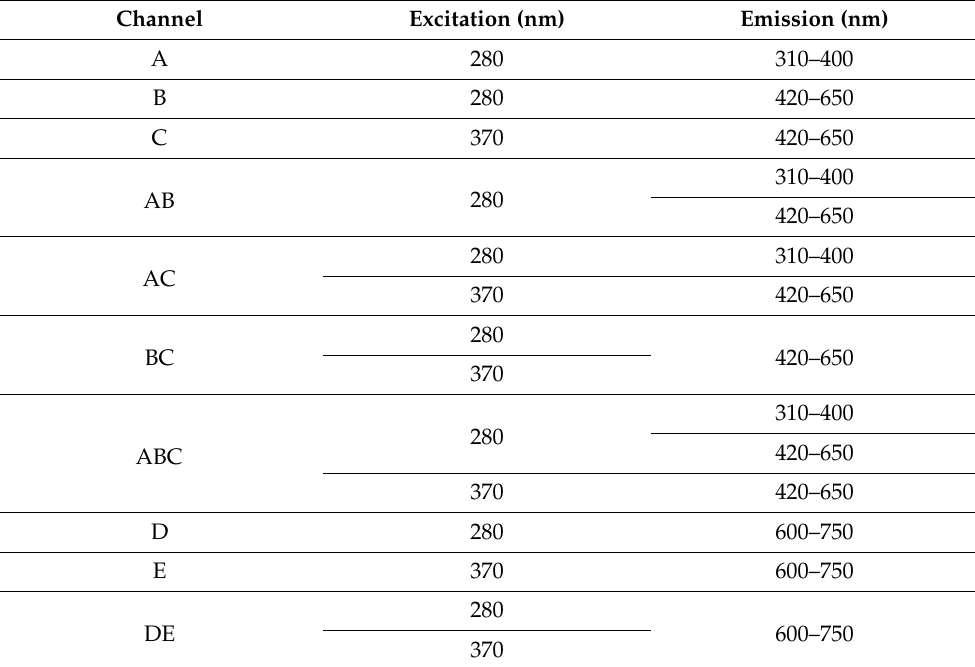
Table 1. WIBS channel annotation matrix. Channels are matched with excitation wavelength and emission